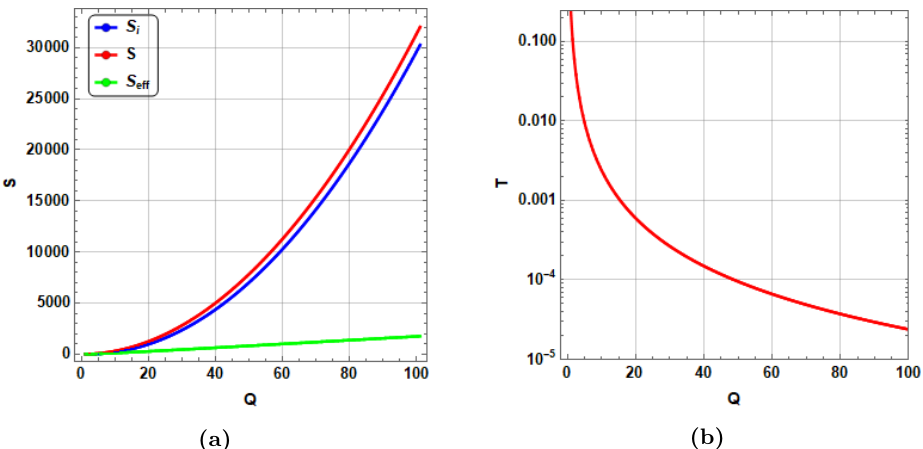
Figure 27. (a) Entropy as a function of black hole charge during absorption of 10 5 particles with a fixed electric charge dQ = 0 . 001 . (b) f min = f ( r min ) in terms of black hole electric charge during absorption of 10 5 particles with a fixed electric charge dQ = 0 . 001 . The initial conditions are Q 0 = 1 , l = 1 , M 0 = 1 . 5 , r h = 1 and D = 4 .